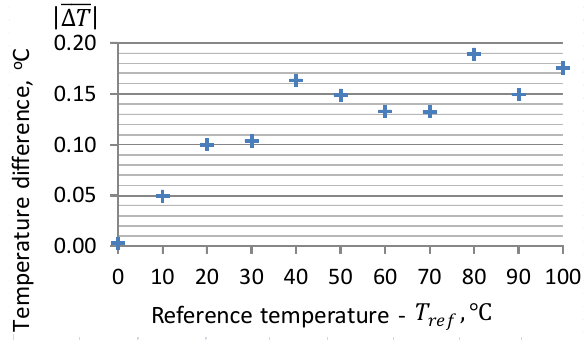
Fig. 9. Mean difference values of temperature measurement ∆(cid:1846)(cid:3364)(cid:3364)(cid:3364)(cid:3364) as a function of the reference temperature T ref.